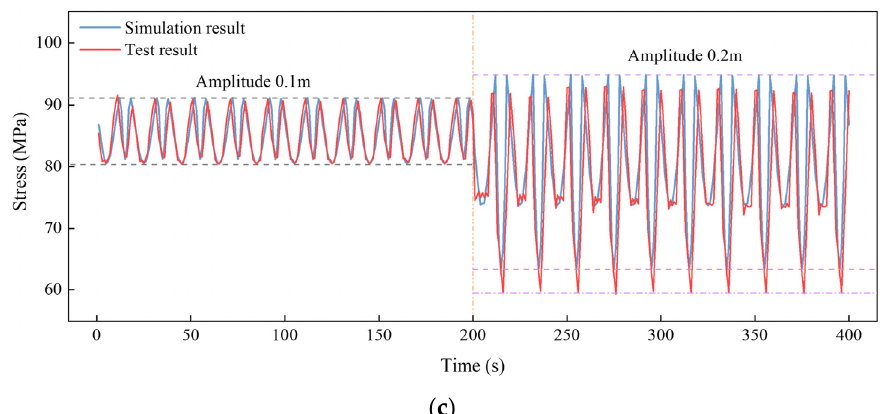
Figure 25. Time histories of the in-plane stress when the amplitude increased from 100 mm to 200 mm: ( a ) S2; ( b ) S5; and ( c ) S8.